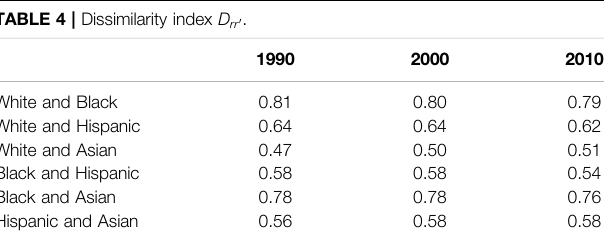
TABLE 4 | Dissimilarity index D rr ′ .